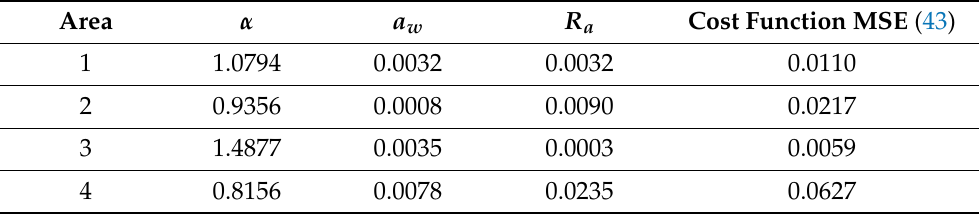
Table 2. Identified parameters of the fractional